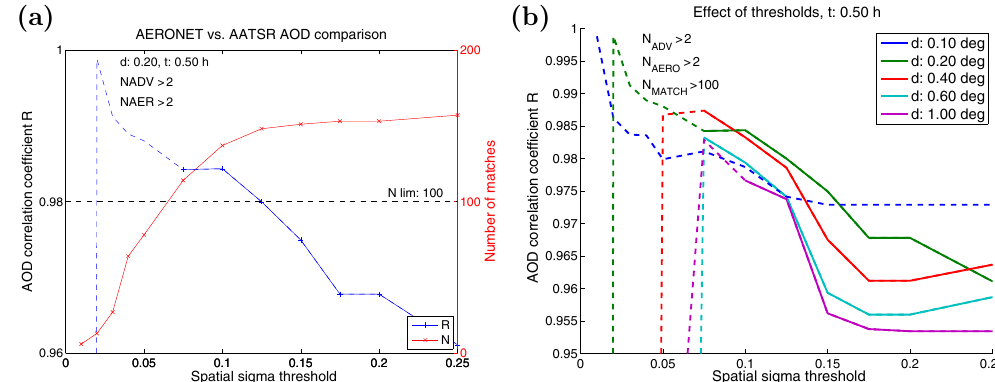
Figure 8. (a) Effect of σ AATSR threshold on the AOD comparison with d = 0 . 2 ◦ and (cid:49)t = 0 . 5h. We have also applied the thresholds N ADV > 2 and N AERO > 2 to ensure sufficient statistics for calculating σ AATSR . The blue line shows the AOD correlation coefficient R (left y axis), and the red line shows the corresponding number of matches N (right y axis) after an upper threshold on σ AATSR ( x axis) has been applied. Results with N < 100 (dashed horizontal black line) are shown by the dashed blue line. (b) The same for various sampling distances. The dashed lines show results for which less than 100 matches are